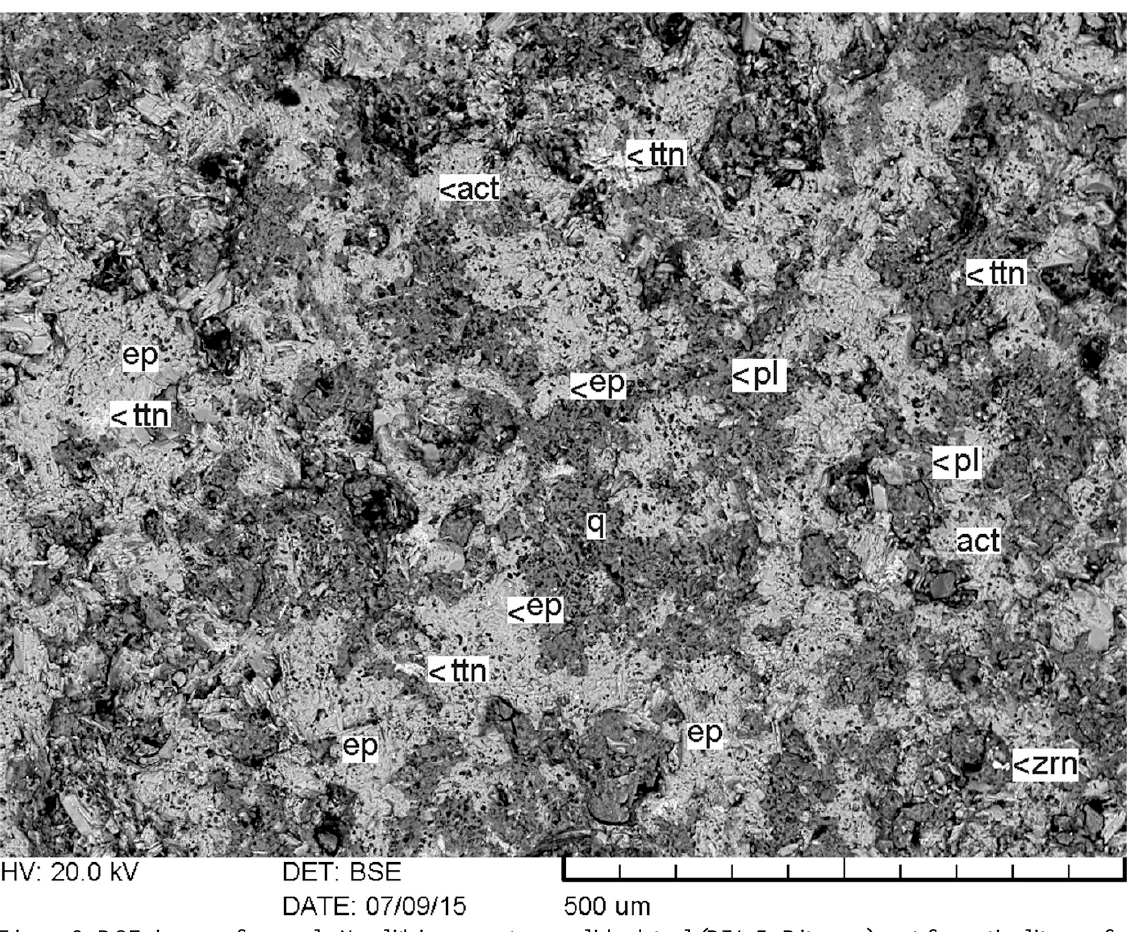
Figure 8. BSE image of an early Neolithic greenstone polished tool (PIV-5, Pitvaros): act for actinolite, ep for epidote, pl for plagioclase, q for quartz, ttn for titanite, zrn for